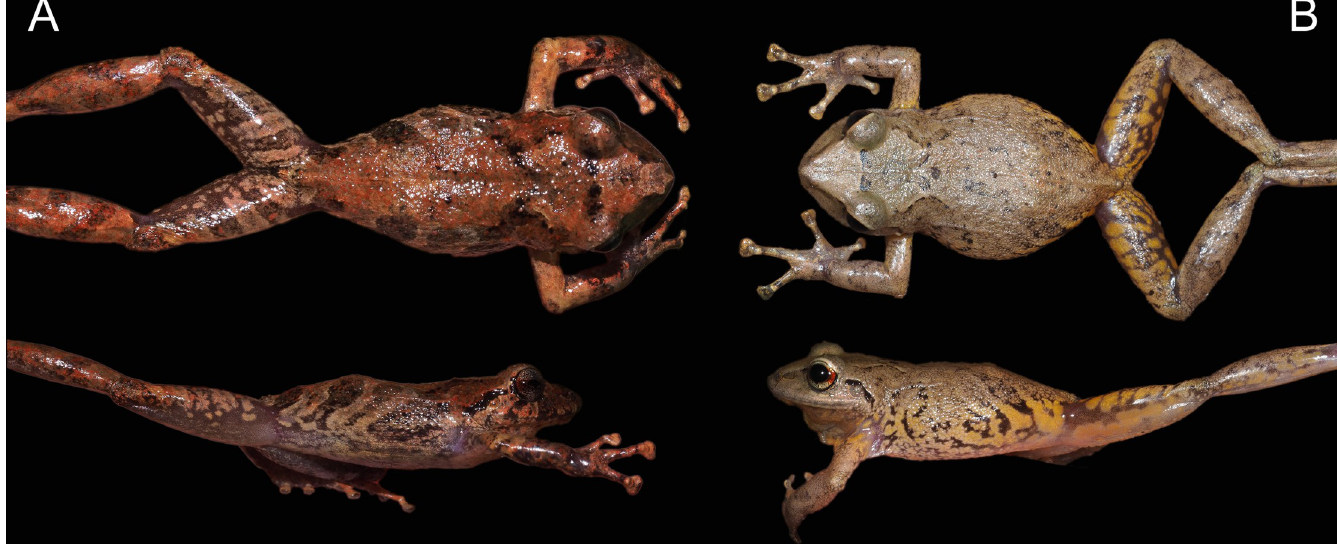
Fig 6. Morphological differences between (A) Pristimantis lojanus sp. nov. (male paratype MUTPL 179) and (B) P . torresi (male, MUTPL 996): no markings in axilla, groin or on concealed limb surfaces vs. yellow markings, and iris bronze vs. iris much lighter, golden. Note: not all P . torresi individuals have these yellow markings however no P . lojanus sp. nov. individuals were found with similar